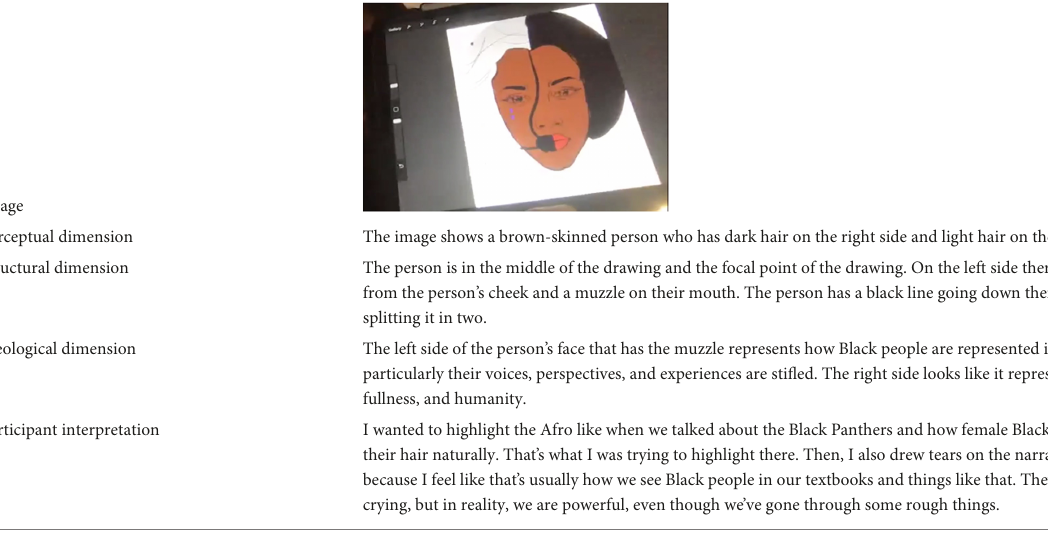
TABLE 2 Example of critical visual analysis coding sheet – Mackenzie’s textbook drawing.